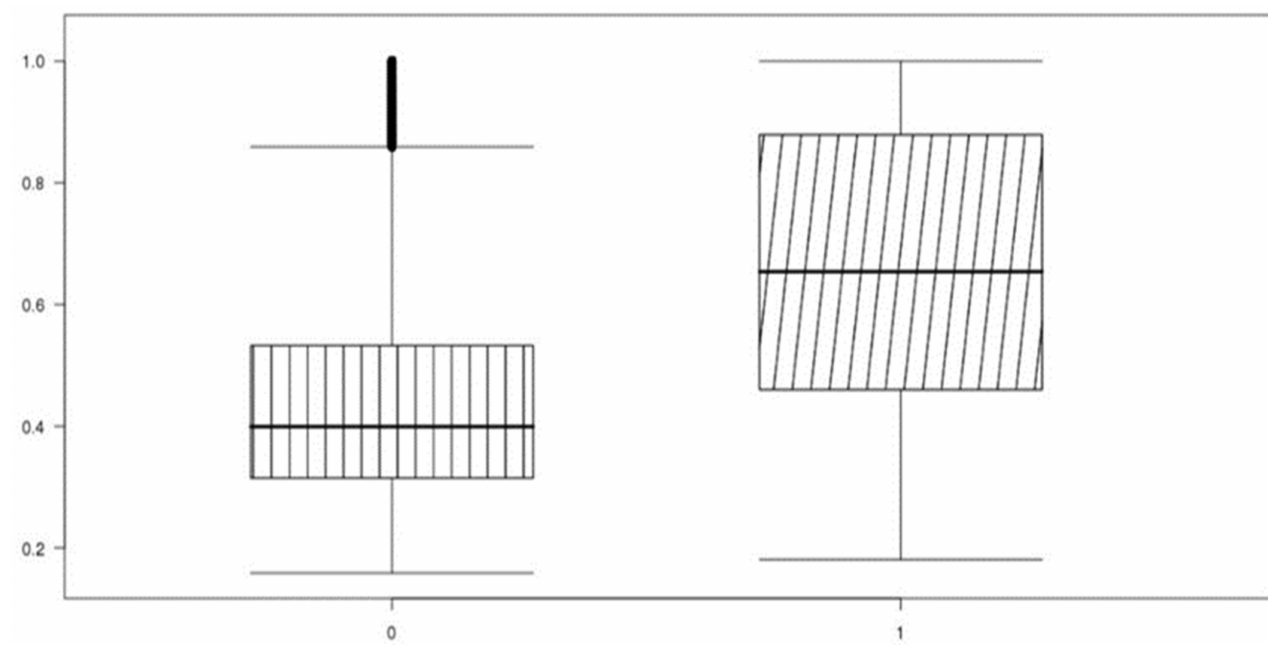
Figure 5. Down-sampling dataset 4 (logistic regression) actual-prediction data distribution box-plot.